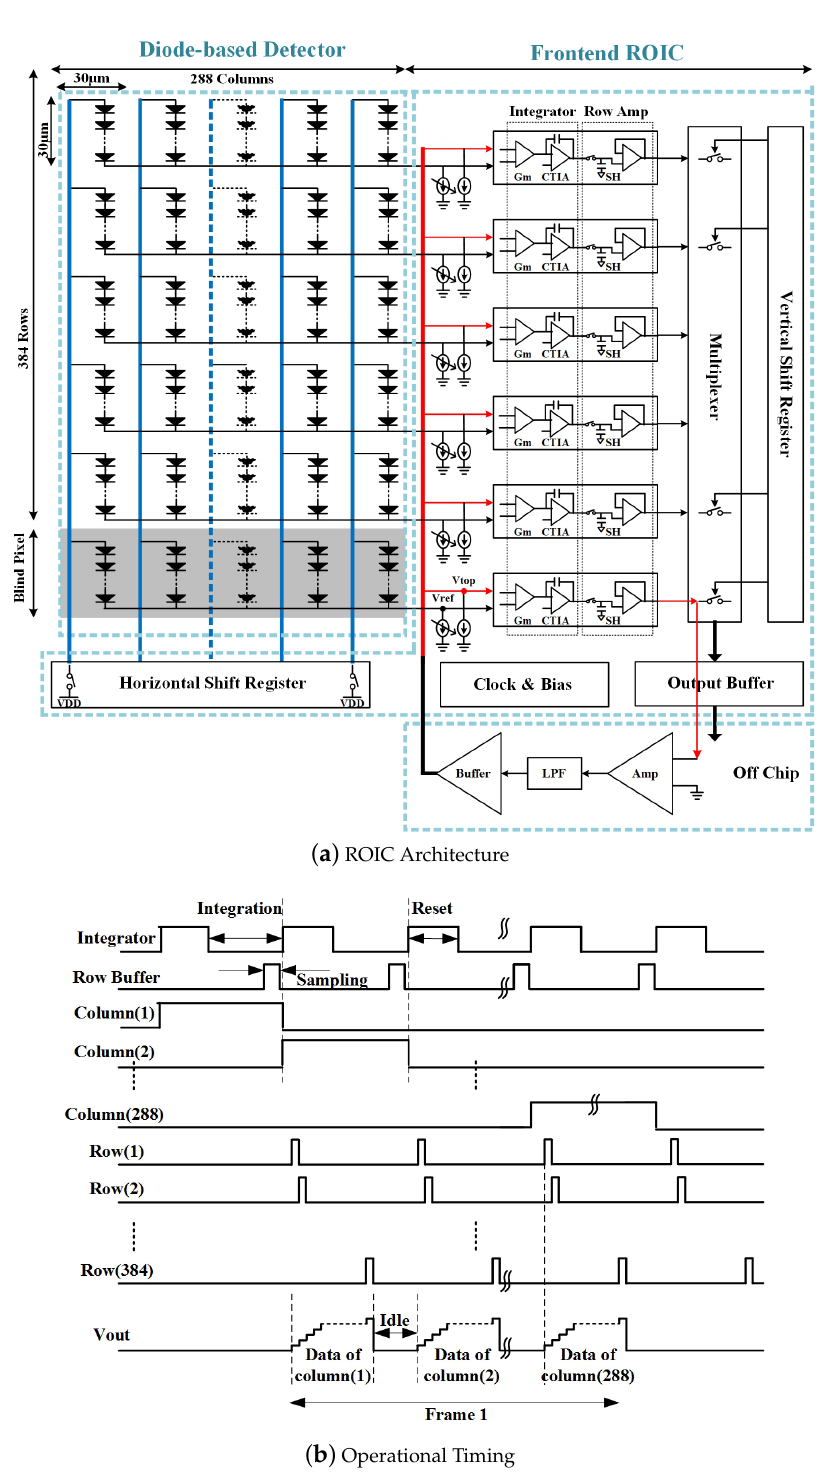
Figure 1. Simplified architecture ( a ) and timing diagram ( b ) of the proposed 384 × 288-frontend